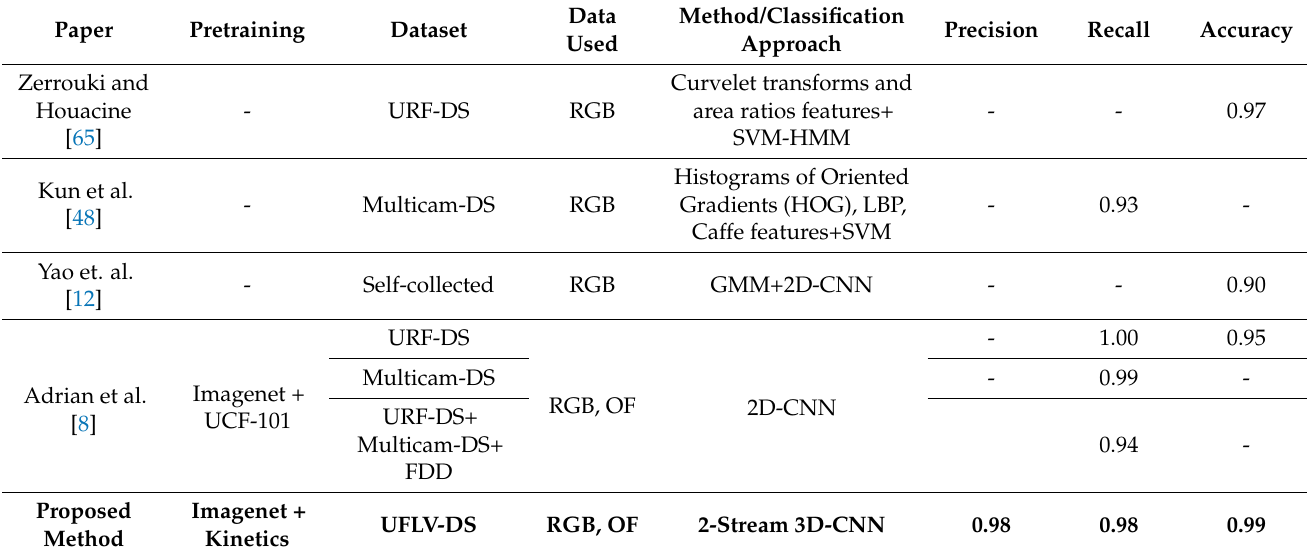
Table 8. Comparison with the state-of-the-art for falling.